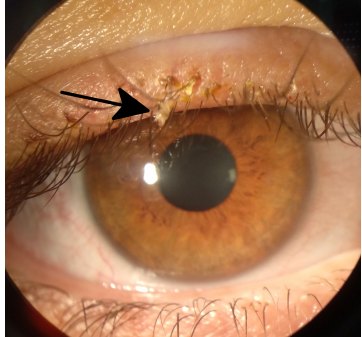
Figure 1: Slit-lamp photography; a translucent mobile Phthirus pubis hanging on the eyelash; blepharitis with scabs is observed too.